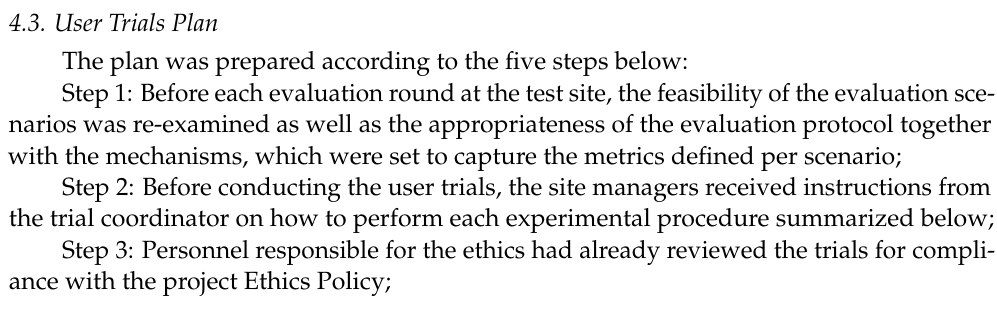
Figure 8. Conduction plan of the user trials.